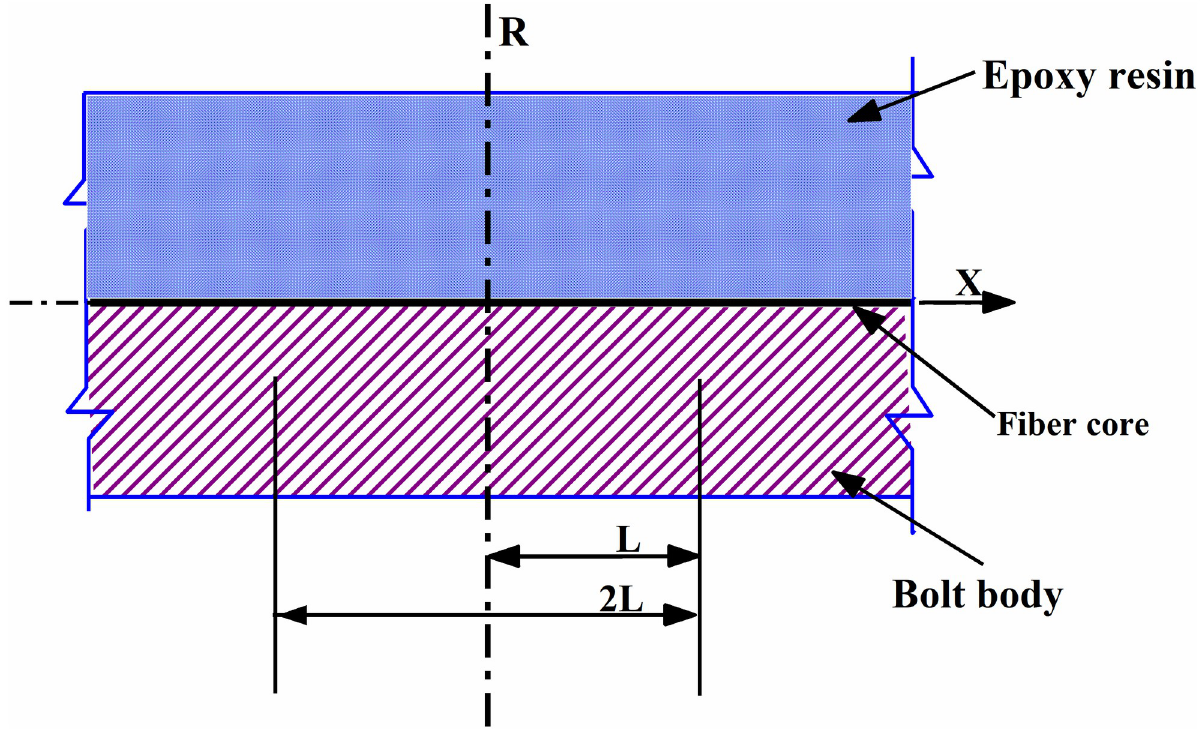
Fig 2. Structure profile diagram.